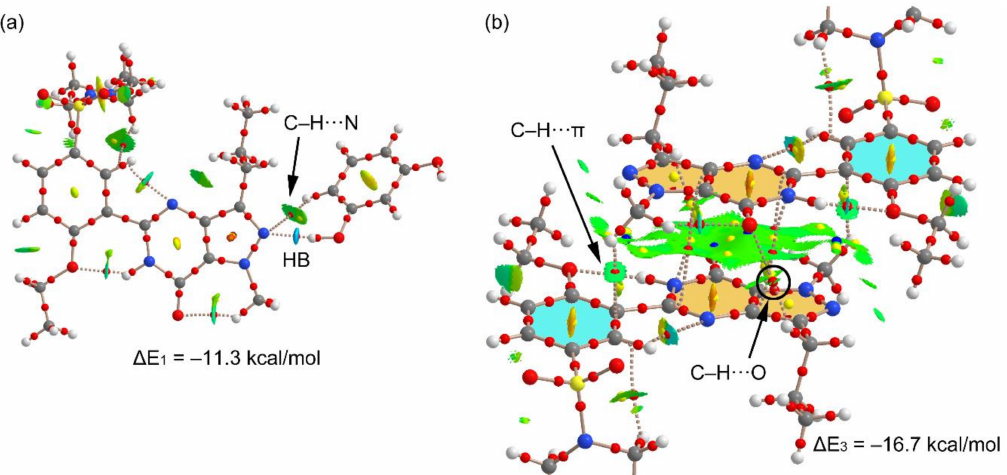
Figure 7. Combined QTAIM (bond, ring, and cage critical points (CPs) represented as red, yellow, and blue spheres, respectively) and noncovalent interaction (NCI) plot analysis ( − 0.04 < sign( λ 2 ) ρ < 0.05) of the H-bonded dimer ( a ) and π -stacking dimer ( b ). NCI plot isosurface = 0.5